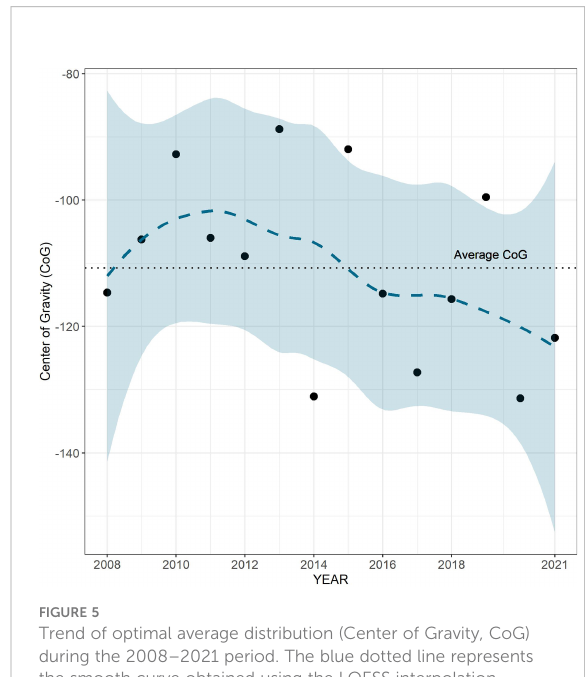
FIGURE 5 Trend of optimal average distribution (Center of Gravity, CoG) during the 2008 – 2021 period. The blue dotted line represents the smooth curve obtained using the LOESS interpolation method, the blue band indicates the 95% con fi dence interval.